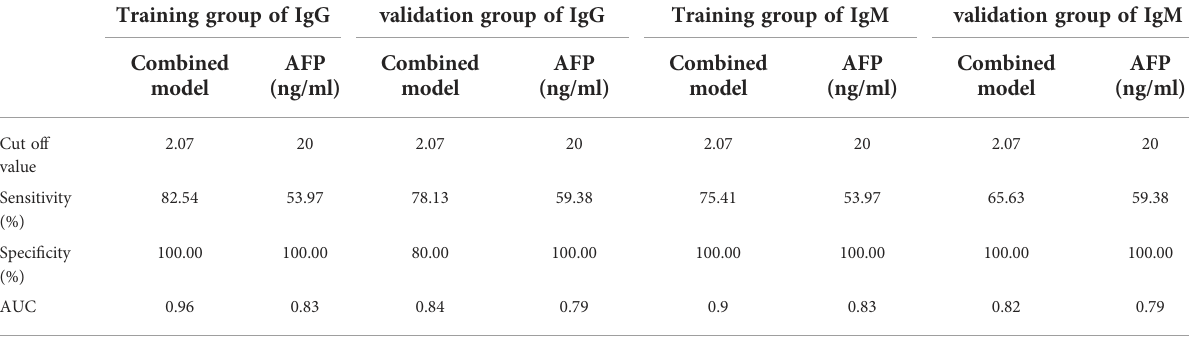
TABLE 4 Modeling evaluation of HCC group versus NC.